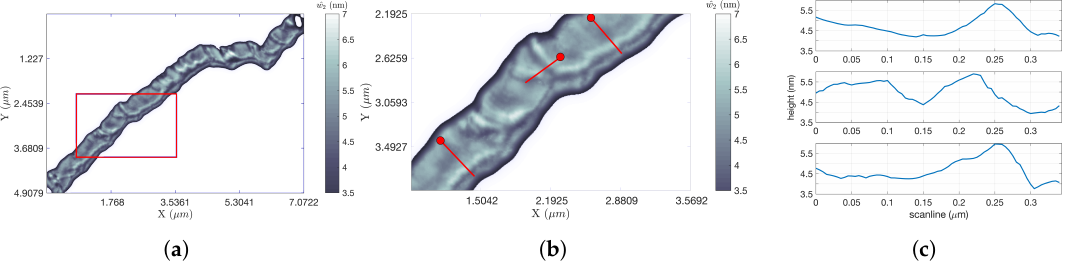
Figure 8. DNA results. ( a ) LCS image. The white background indicates no information. The scan proceeded from the lower right to the upper left; the circular shape of the scan is revealed in the end of the image with the circular shape in the reconstructed image (LCS ˆ w 2 image, ω = 60 Hz); ( b ) A zoom in of the red box in ( a ) to show the detail (zoom of the red rectangle in ( a )); ( c ) Three hundred forty five nanometer-long scans generated from along the three red lines in ( b ). The top scan corresponds to the line in the top right, the middle scan to the line in the middle and the bottom scan to the line on the bottom. Each scan began at the end indicated by a circle (line scans along red lines in ( b